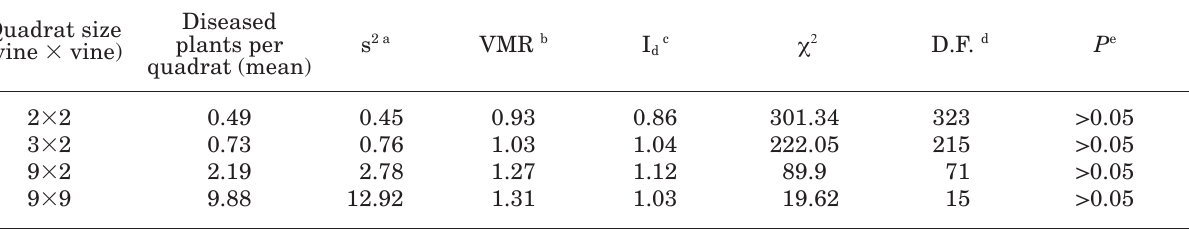
Table 2. Indices of dispersion (VMR and I for the study